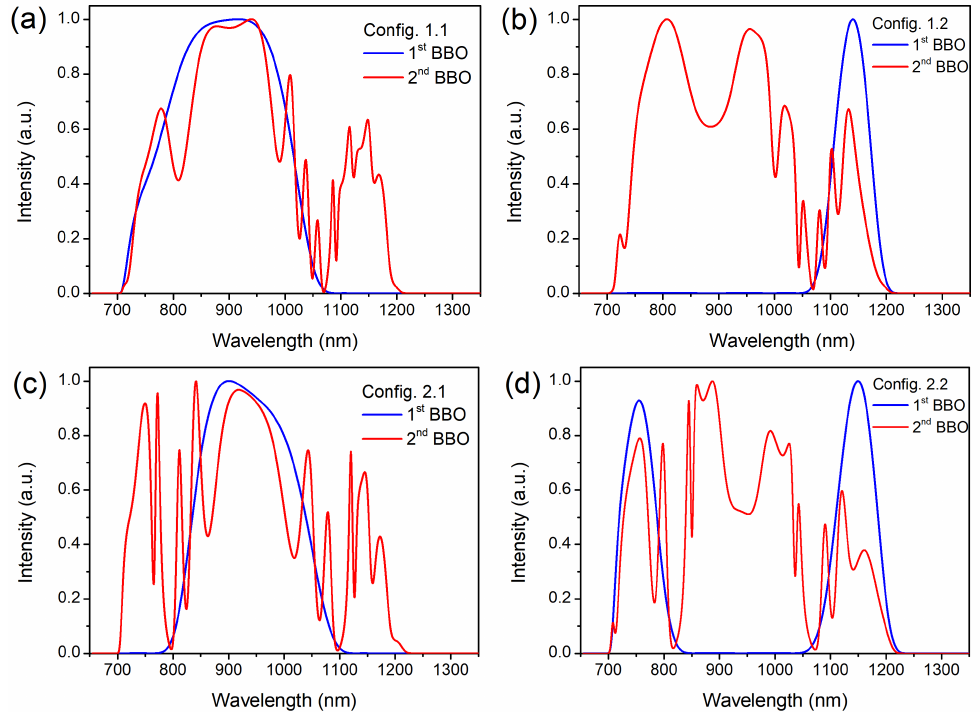
Figure 5. ( a ) Cascaded spectrum in Config 1.1, ( b ) in Config 1.2, ( c ) in Config 2.1 and ( d ) in Con- fig 2.2. The blue and red line represent the spectrum at the exit of the first and the second BBO crystal